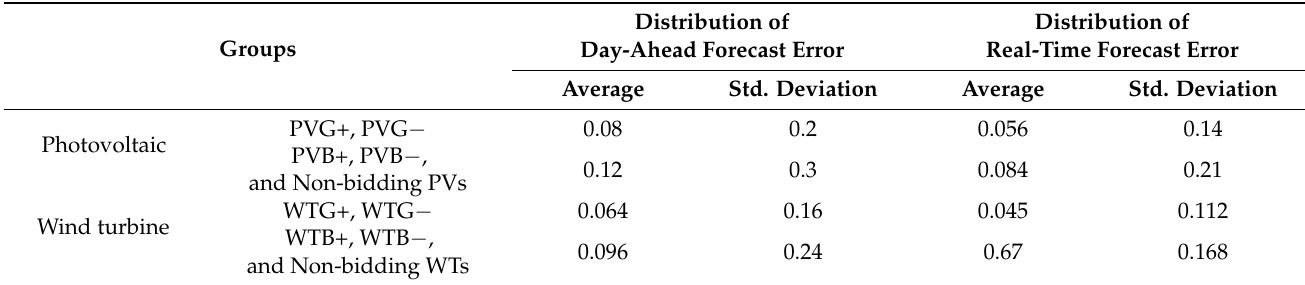
Table 2. Gaussian distribution of each group’s forecast error.